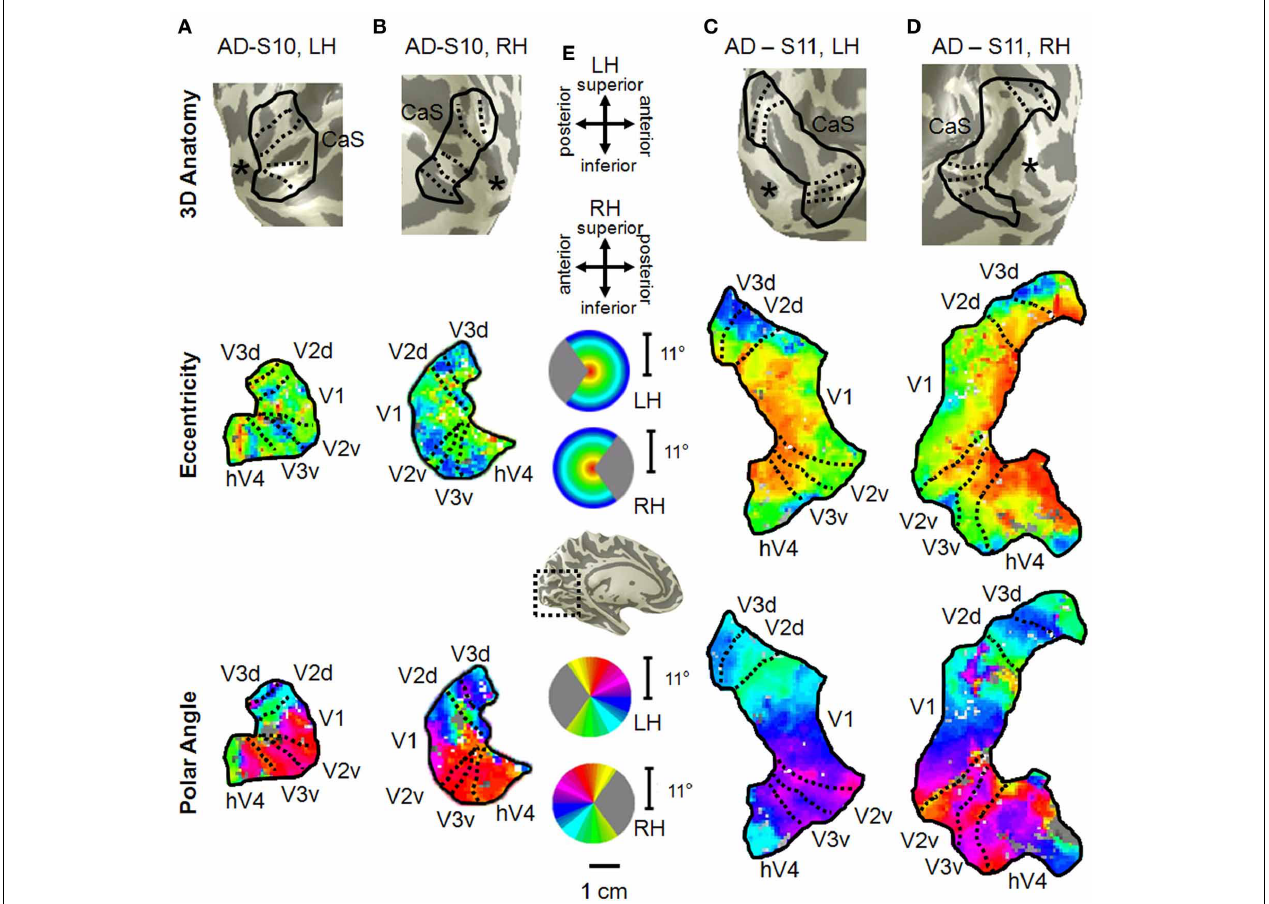
FIGURE 10 | Visual field map measurements in mild Alzheimer’s disease subjects. Occipital VFMs V1, V2, V3, and hV4 are shown for the left (A) and right (B) hemispheres of a single subject with mild AD (S10). While the polar angle gradients (bottom panel) still contained the expected representations of contralateral visual space with orderly reversals between VFMs, the eccentricity measurements (middle panel), drawn from the same fMRI scans, were more disorganized. Also note the visibly smaller size of these